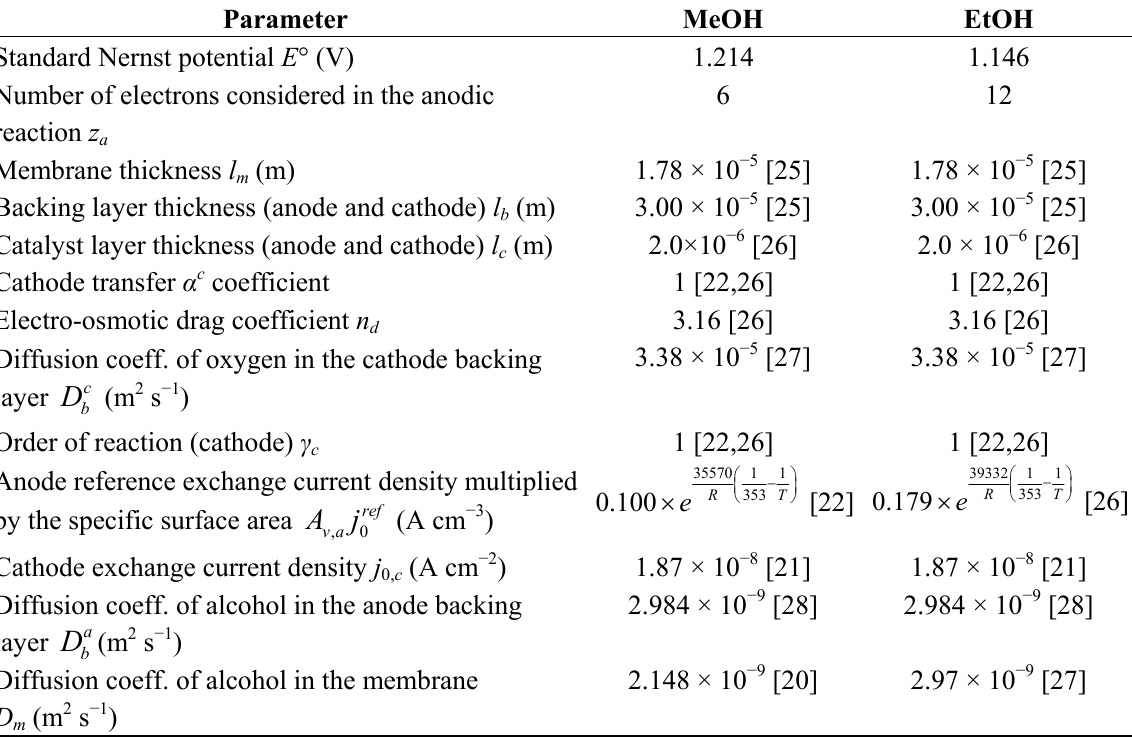
Table 2. Assumed parameter values for MeOH and EtOH.